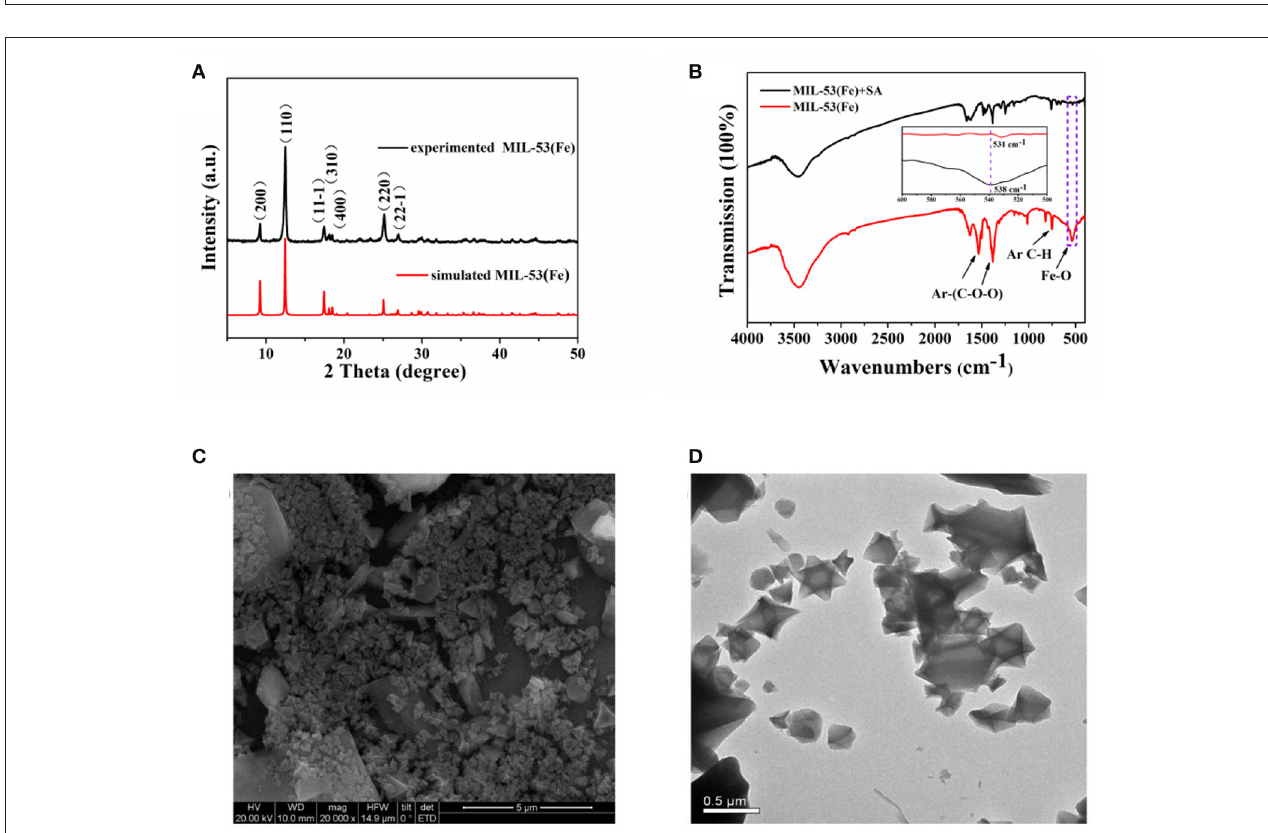
FIGURE 2 | (A) PXRD patterns of the as-prepared MIL-53(Fe) (black curve) and the simulated MIL-53(Fe) (red curve), (B) FTIR spectra of MIL-53(Fe) and MIL-53(Fe) + SA, (C,D) depicting the SEM and TEM images of MIL-53(Fe), respectively.